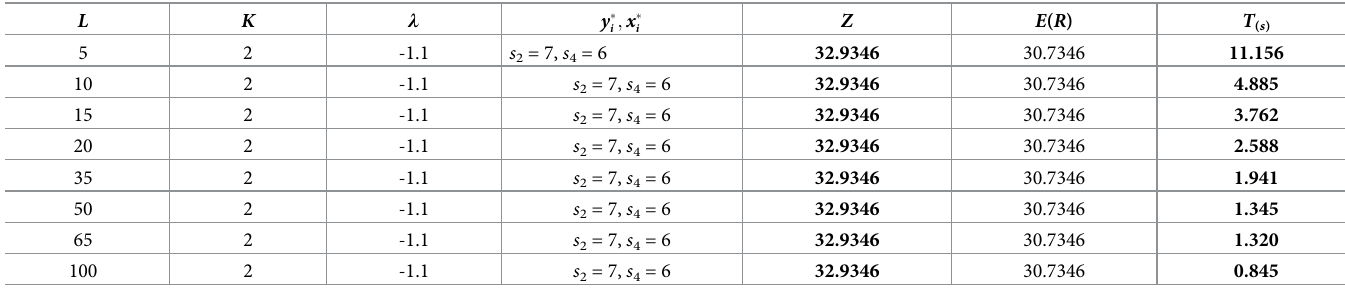
Table 2. Sensitivity analysis of environmental shares.